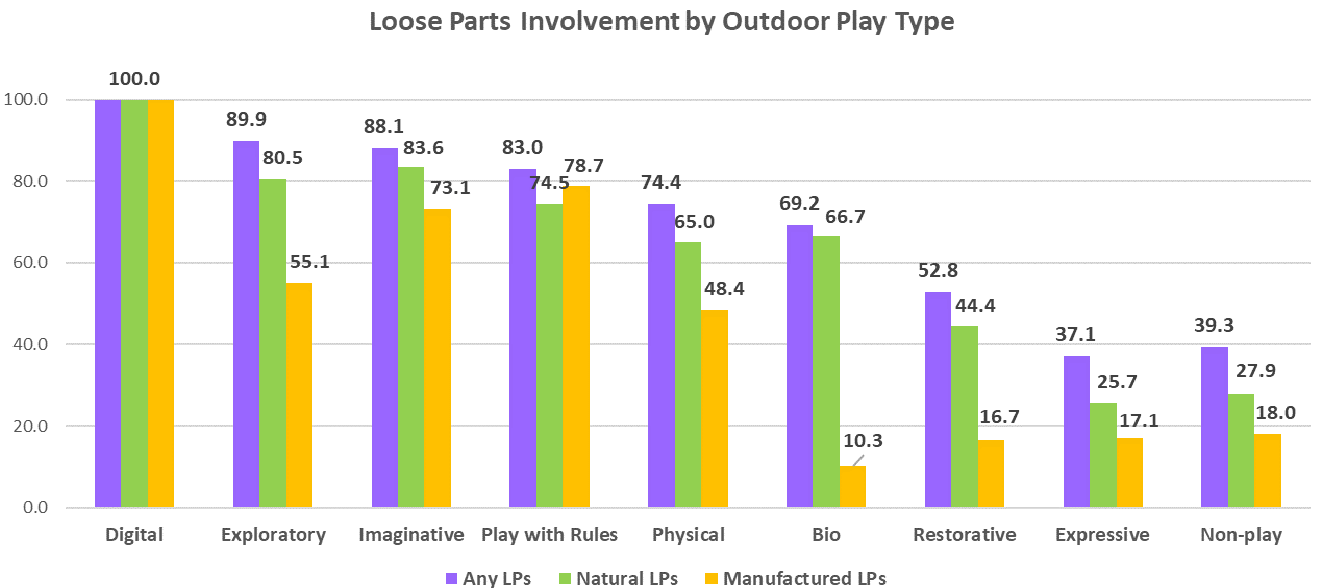
Figure 10. Outdoor play type by risk behavior.